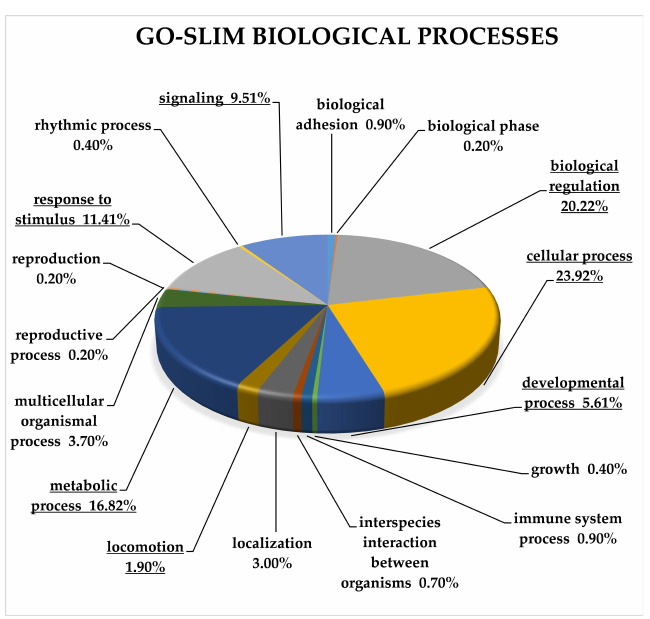
Figure 3. GO-Slim analysis of target genes of up-regulated miRNAs in CRC. Classification is ac- cording to biological processes terms. Significantly overrepresented terms are underlined ( p < 0.05; FDR < 0.05). FDR—false discovery